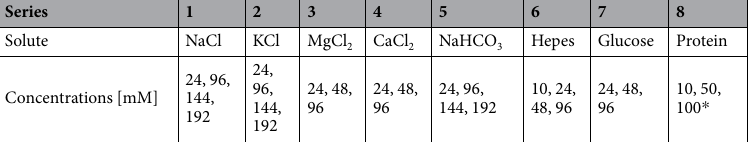
Table 1. Details of the ionic solutions analyzed by Raman micro-spectroscopy. *